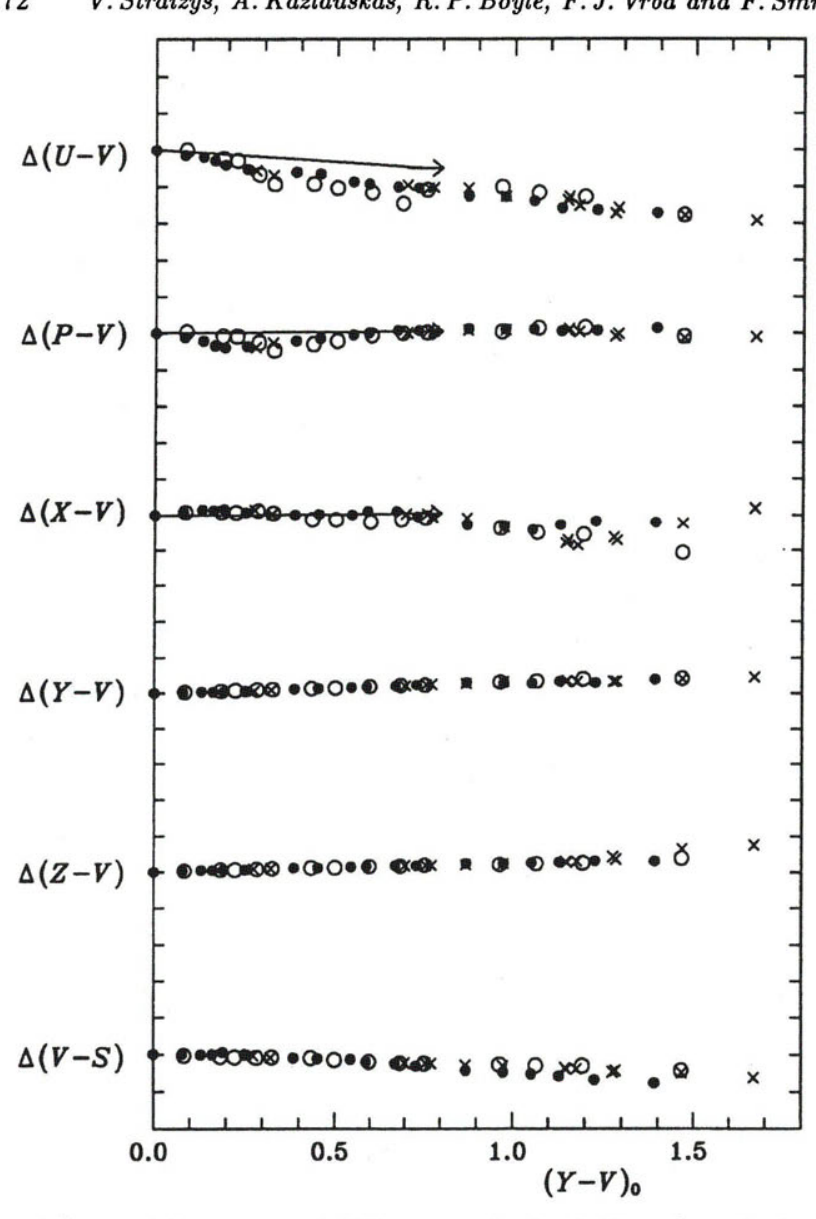
Fig. 2. The computed differences of color indices (standard minus CCD) plotted against Y-V. Dots are for main sequence stars, crosses are for giants and circles are for supergiants. Arrows are reddening lines for A( JJ-V), A ( P - V) and A(X-F). In the case of other color differences, the reddening lines run exactly along the sequence of unreddened stars. On both axes the ticks at each 0.1 mag are